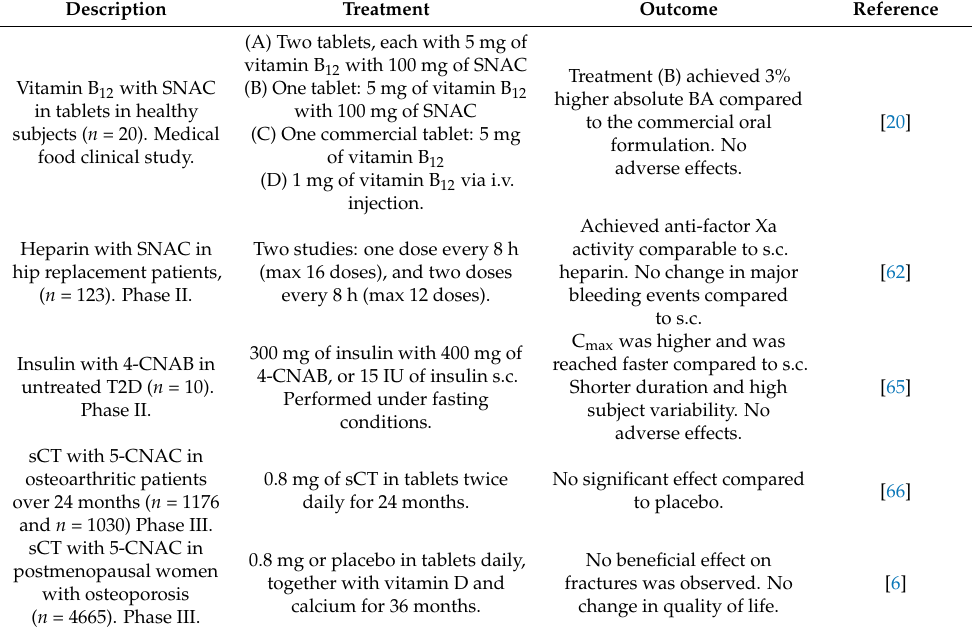
Table 2. Summary of data from selected studies in humans reported for a range of poorly permeable molecules formulated with either salcaprozate sodium (SNAC), monosodium N